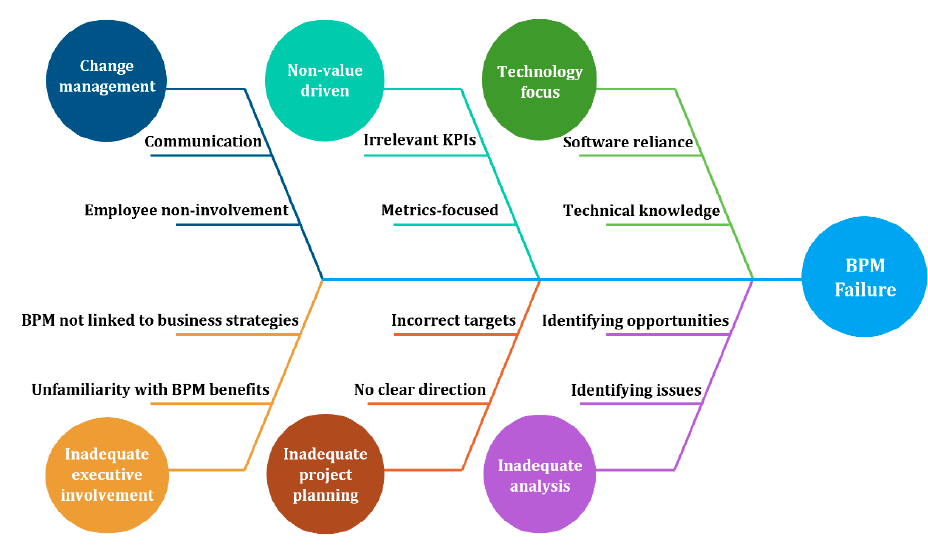
Figure 4. Cause and effect diagram for the failure of business process management (BPM) initiatives.